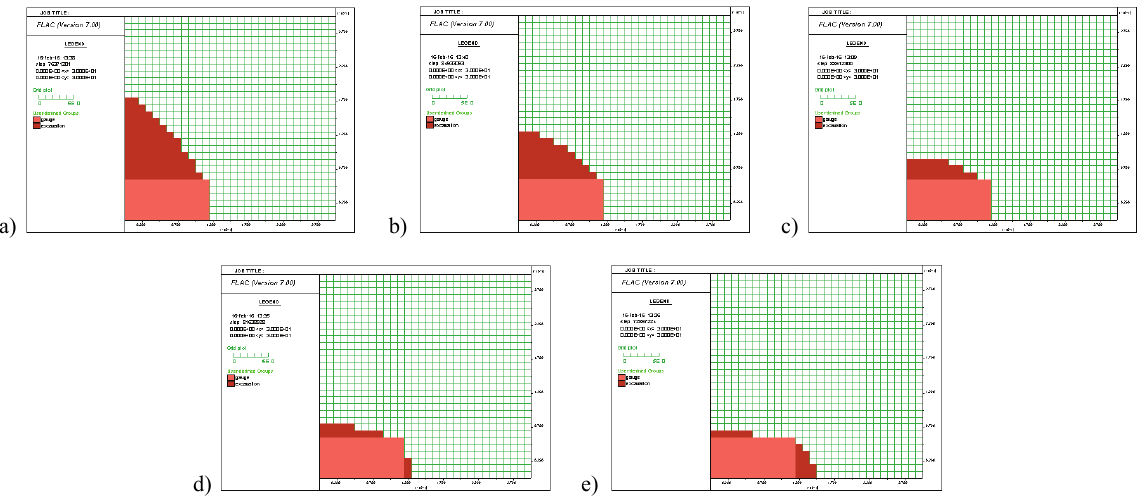
Fig. 4. Optimal shapes of excavation: (a) p x / p z = 1/4, (b) p x / p z = 1/2, (c) p x / p z = 1, (d) p x / p z = 2, (e) p x / p z =